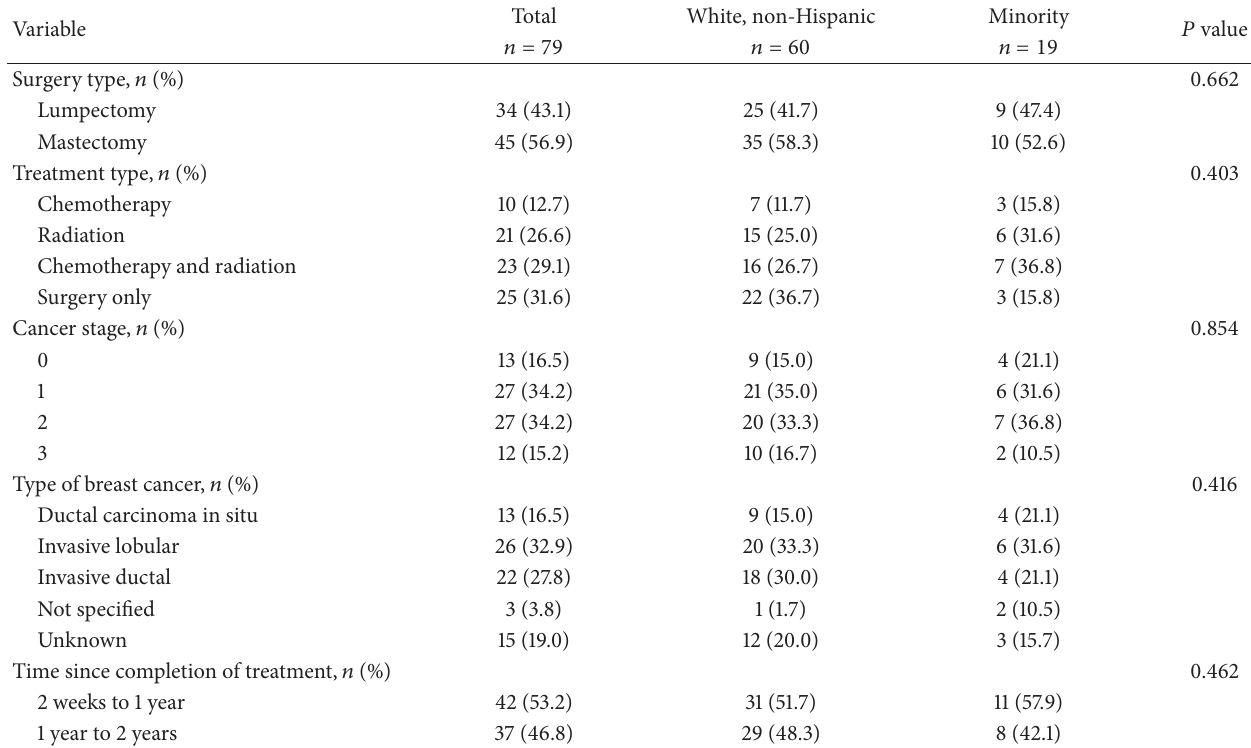
Table 1: Surgery type, treatment type, stage of cancer, type of breast cancer, and time since completion of treatment of participants by race/ethnicity ( 𝑁 = 79